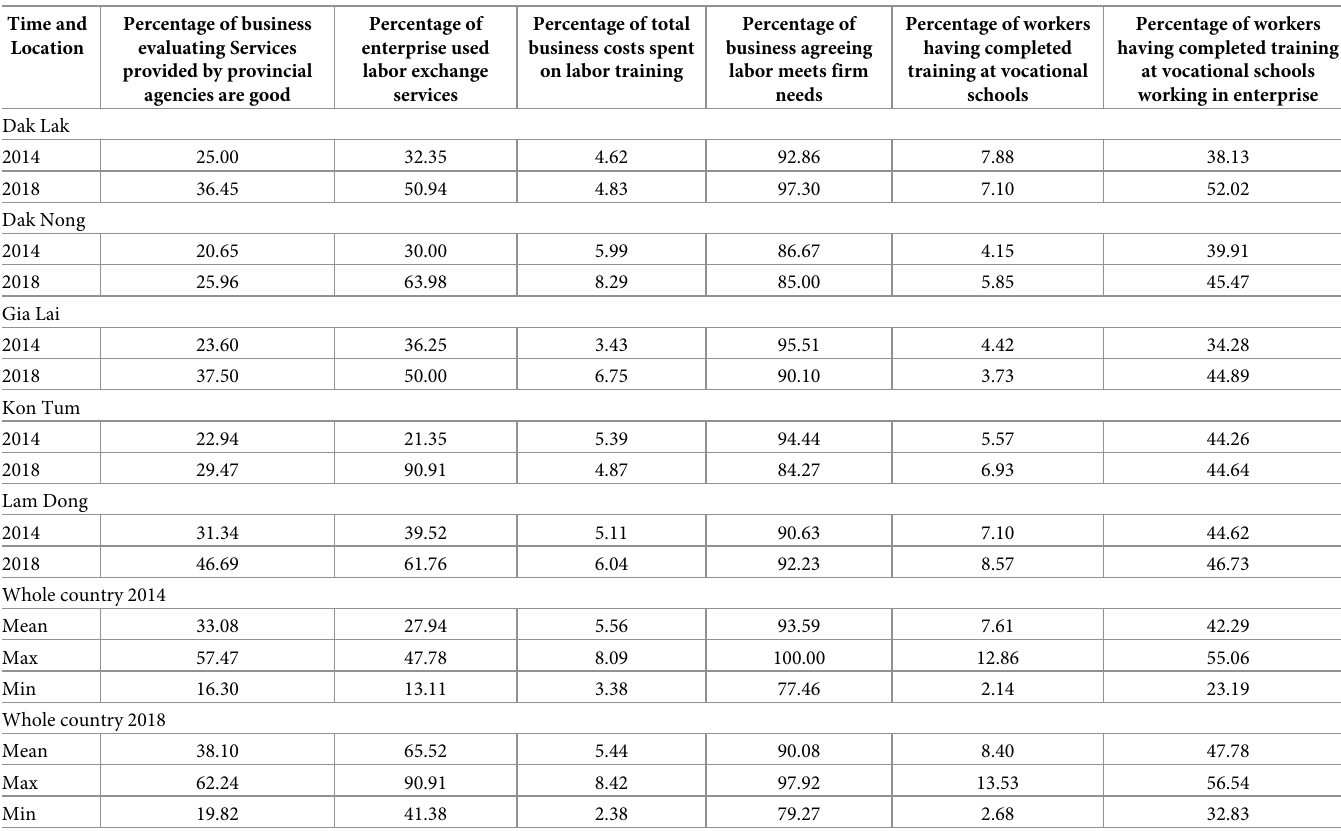
Table 3. Indicators in “labor training” sub-index in the Central Highlands. Unit: %. Time and